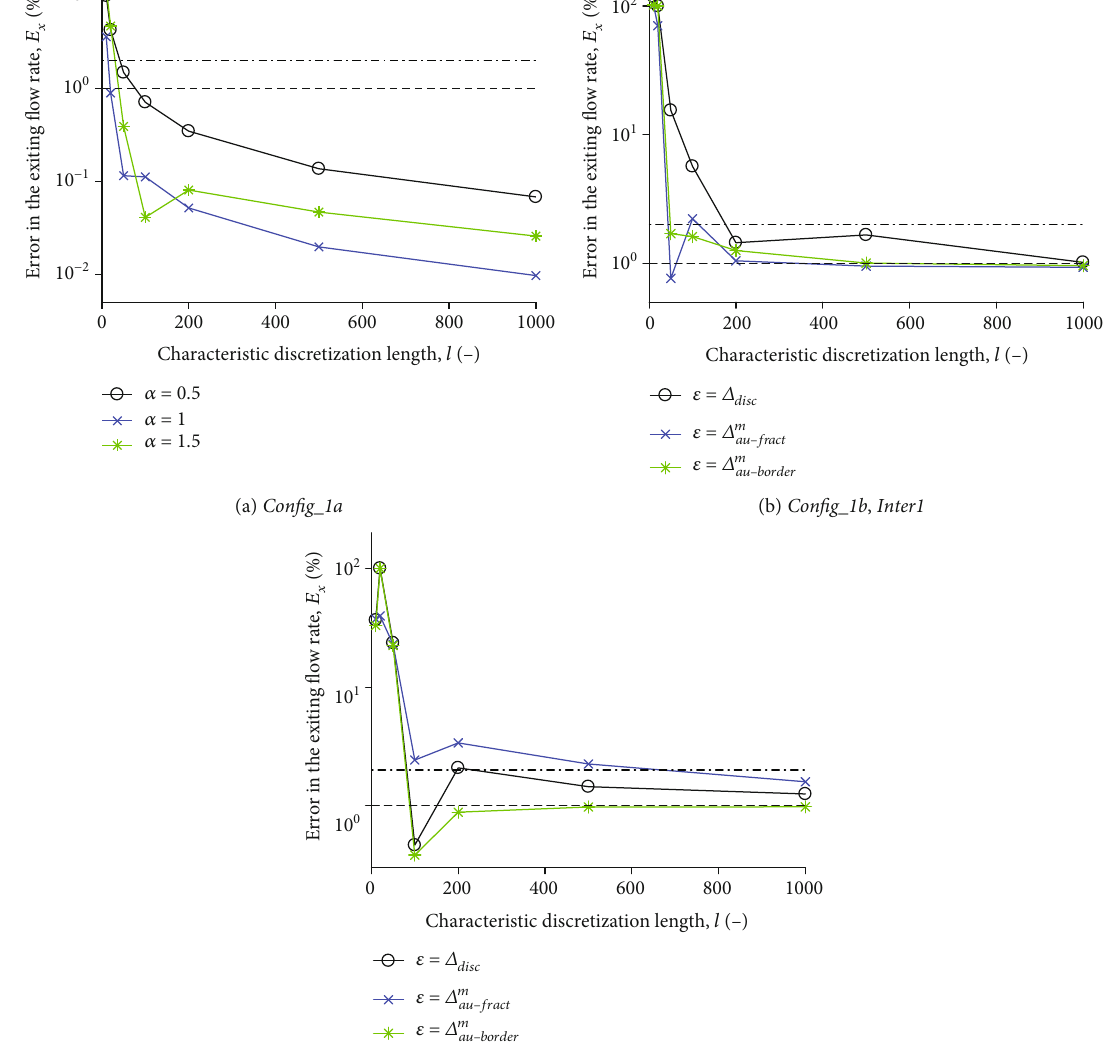
. (a) The relationship ε = αΔ is tested disc disc